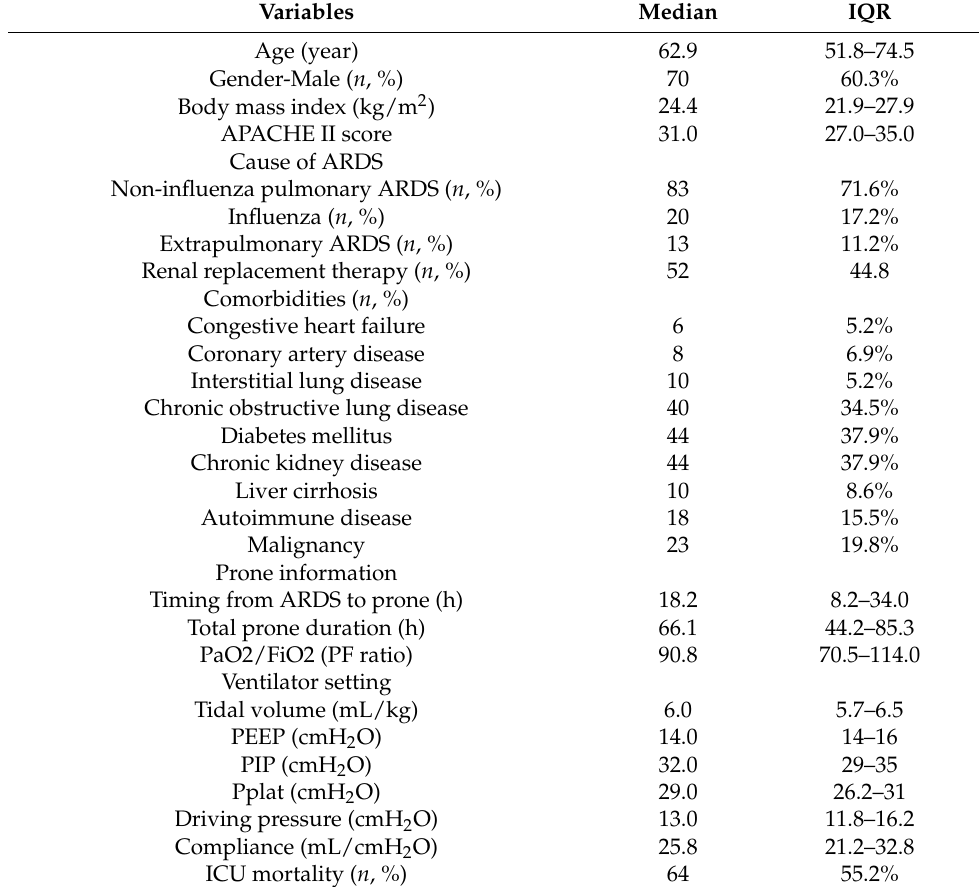
Continuous data are expressed as median and IQR. Categorical data were expressed number and percentage. CHF, congestive heart failure; CAD, coronary artery disease; ILD, interstitial lung disease; COPD, chronic obstructive pulmonary disease, DM, diabetes mellitus; CKD, chronic kidney disease; PEEP: positive end-expiratory pressure; PIP, peak inspiratory pressure; Pplat, plateau